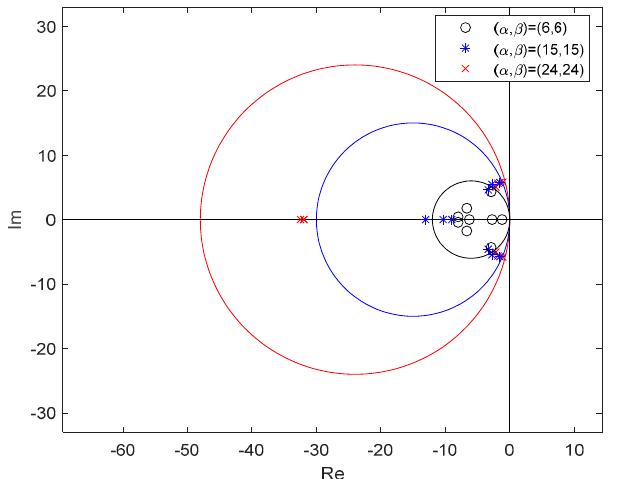
Figure 8. The comparisons of pole locations with different circle regions.